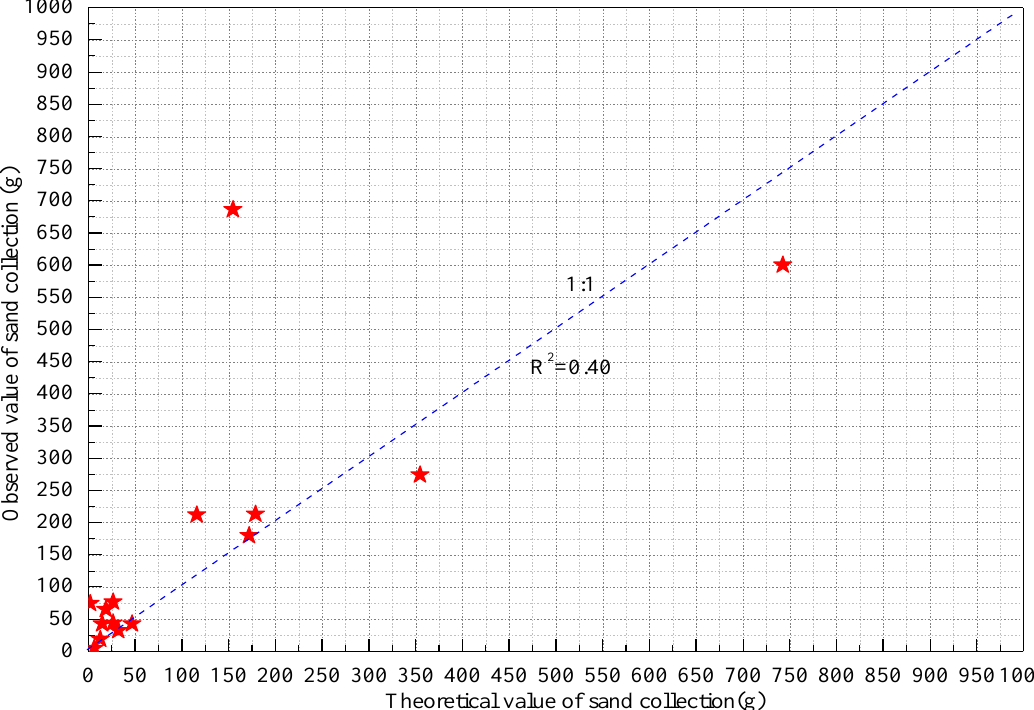
Figure 7. Relationship between theoretical and observed sand